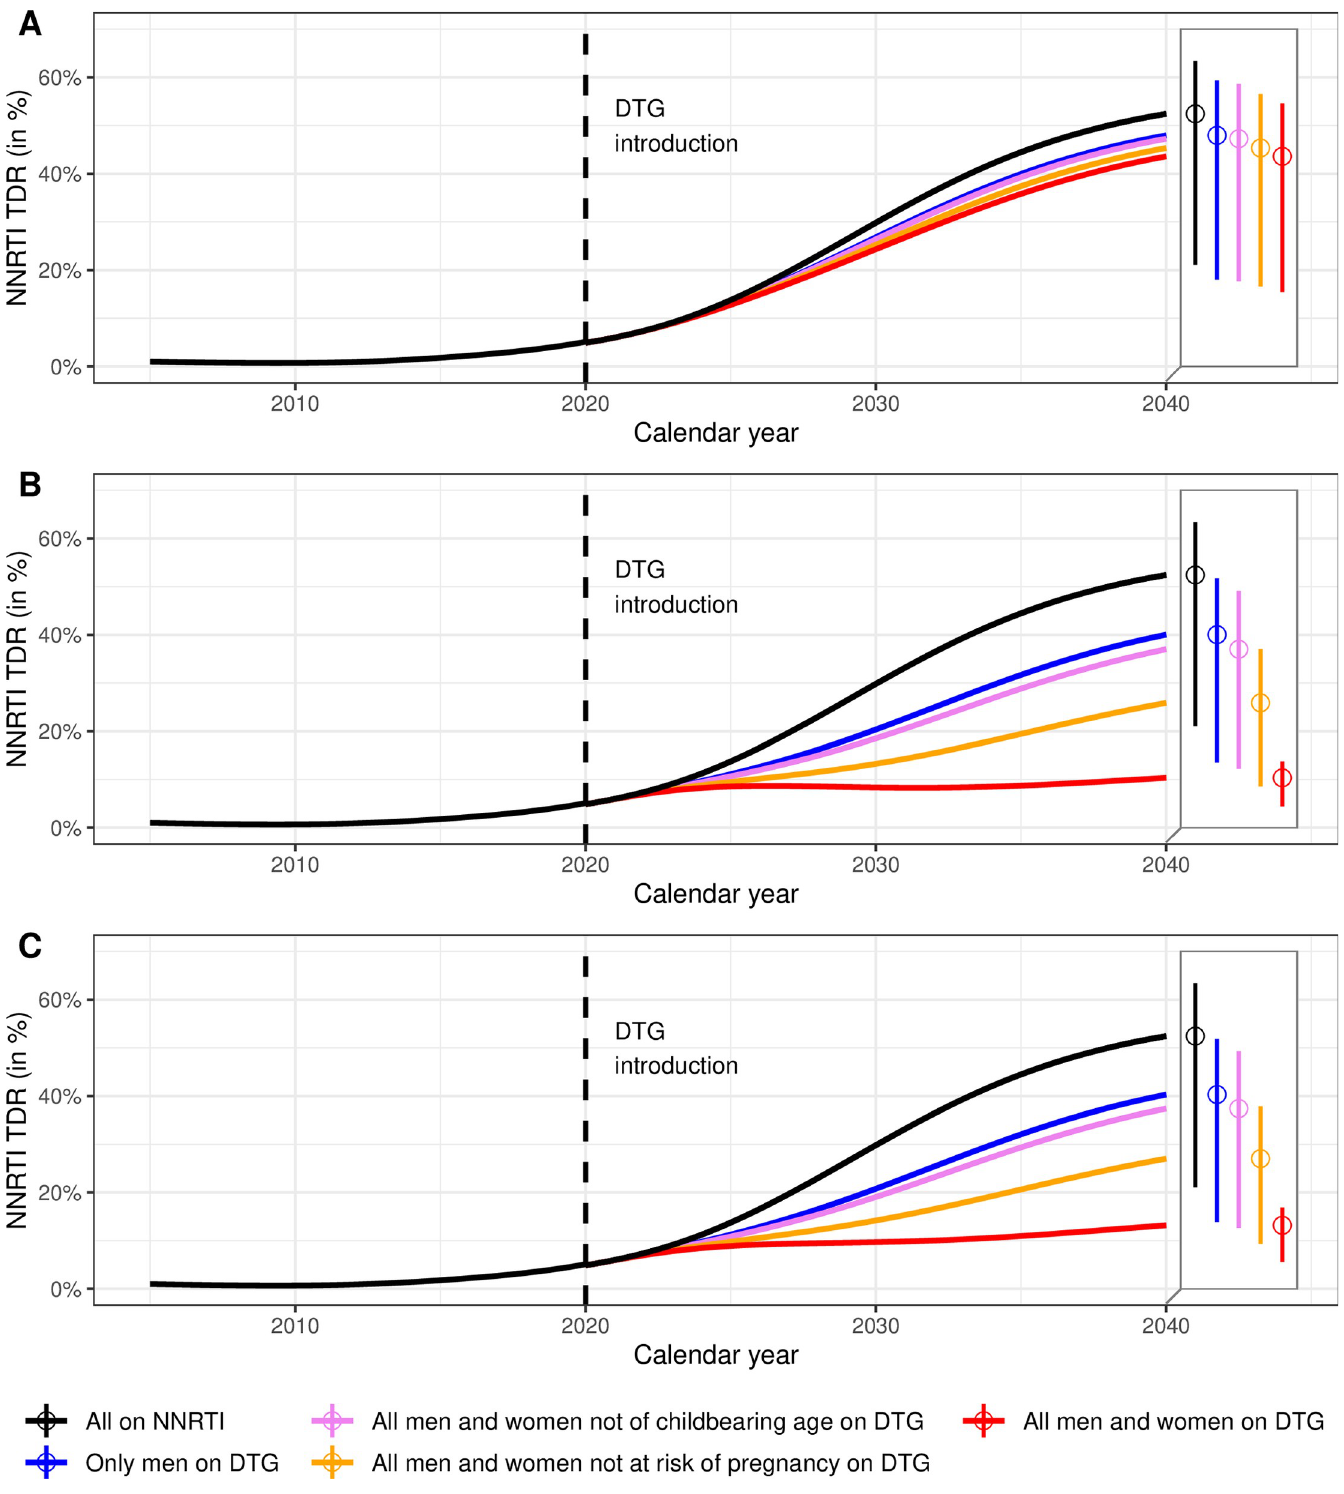
Fig 3. Predicted levels of NNRTI PDR in South Africa 2005–2040. DTG is introduced in 2020 under 3 scenarios: DTG as first-line regimen for ART-initiators (panel A), DTG for all patients (panel B) or DTG for all patients, assuming an impact of NRTI resistance on DTG-efficacy (panel C), and with different eligibility criteria for women (colors). The baseline model shows the situation without the introduction of DTG (black line). The 2 boxes on the right of each panel represent the levels of NNRTI PDR in 2040 and their 95% sensitivity ranges. ART, antiretroviral therapy; DTG, dolutegravir; NNRTI, non-nucleoside reverse transcriptase inhibitor; NRTI, nucleoside reverse-transcriptase inhibitor; PDR, pretreatment drug resistance. https://doi.org/10.1371/journal.pmed.1003397.g003 PLOS Medicine| https://doi.org/10.1371/journal.pmed.1003397 December14,